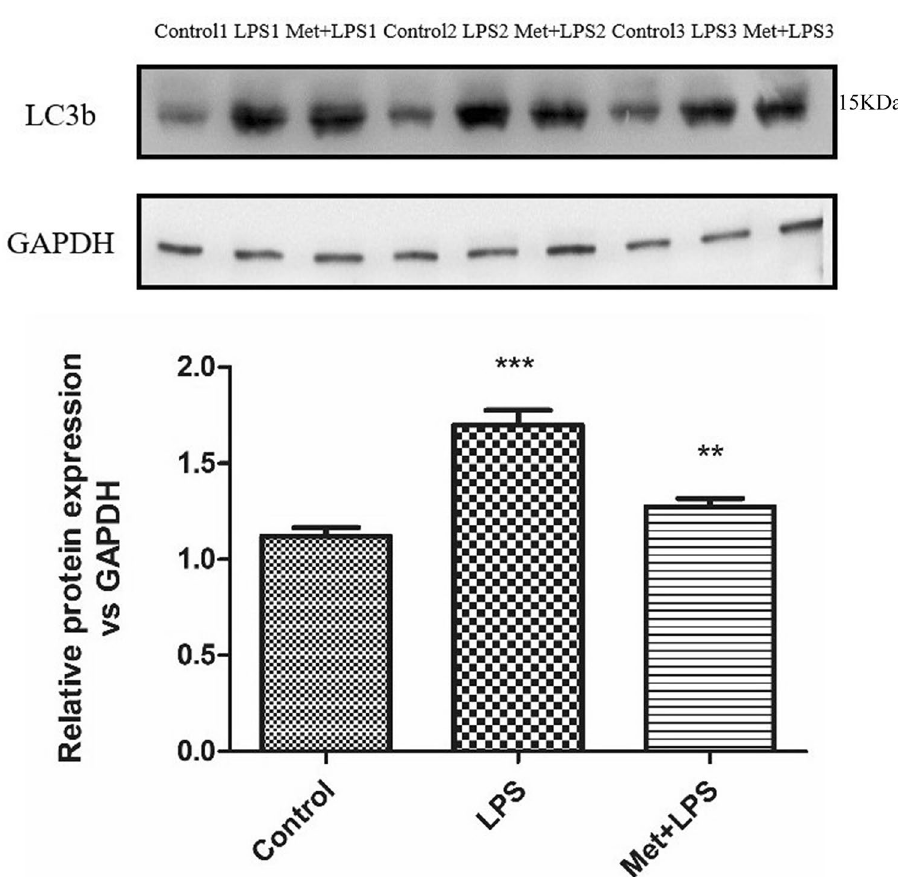
Figure 5. Effects of lipopolysaccharide and metformin on autophagy-related protein LC3b in macrophages. GAPDH: glyceraldehyde-3-phosphate dehydrogenase, LPS: lipopolysaccharide, Met: Metformin, LC3b: microtubule associated protein 1 light chain 3 beta. LPS group: compared with blank control group. Met + LPS group: compared with LPS group. * P < 0.05, ** P < 0.01, *** P <